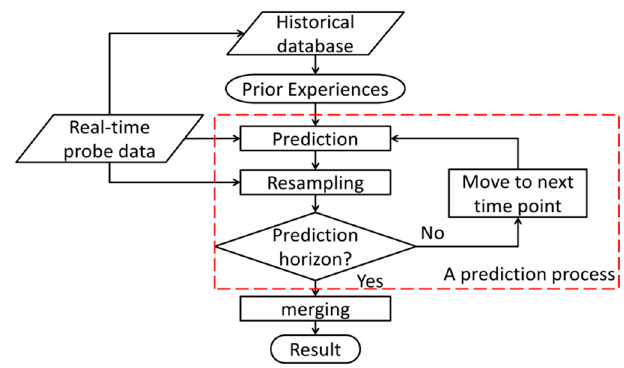
Figure 2. Framework of the proposed model.